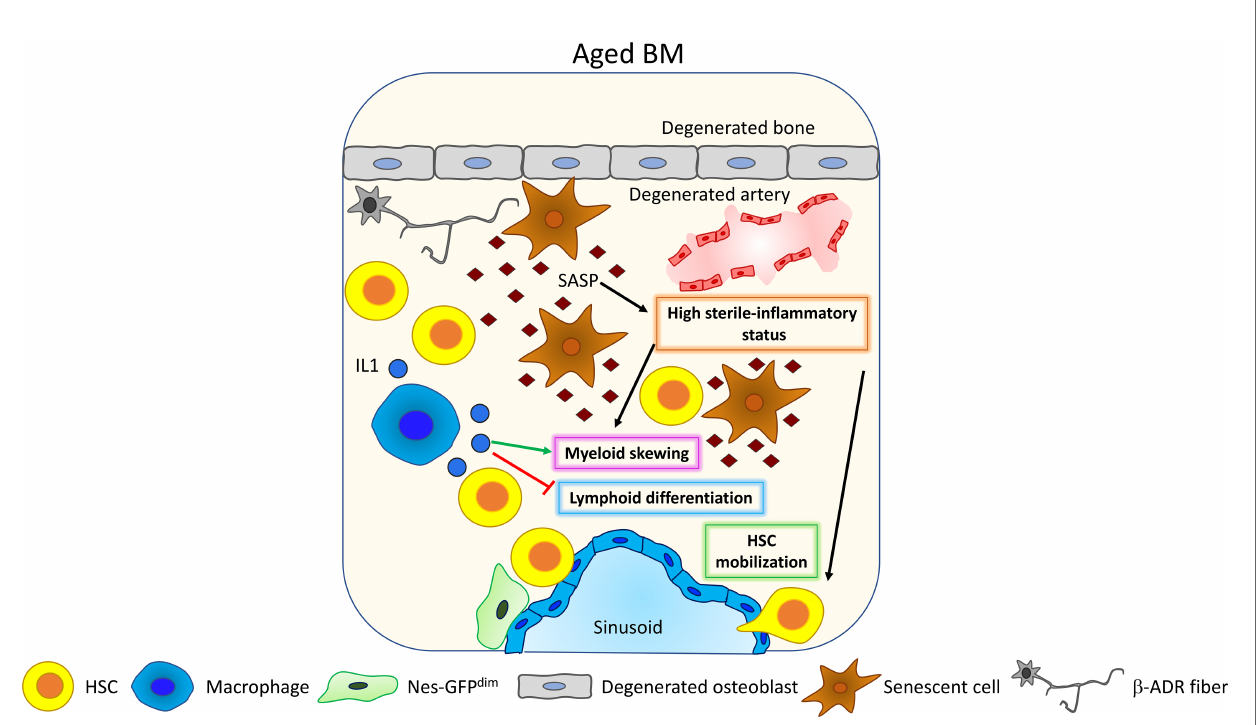
FIGURE 4 | In fl ammaging. Upon aging, senescent cells accumulate and acquire the so-called senescent-associated secretory phenotype (SASP) (89). SASP contains different pro-in fl ammatory factors that increase the general level of sterile in fl ammation within the BM, promoting HSC myeloid differentiation skewing (81) and HSC mobilization (91, 92). Interestingly, HSC myeloid differentiation skewing is also affected by macrophage ’ s activity. Upon aging, macrophages increase their release of IL1 thus promoting HSC myeloid differentiation skewing (93) and inhibiting lymphoid differentiation